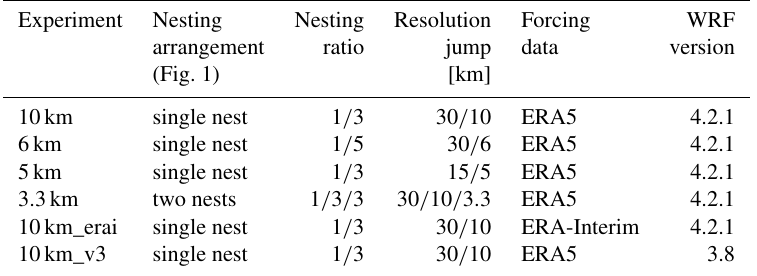
Table 1. Experiment names and the WRF model configuration. The nesting ratio refers to the grid of the relative parent domain, as shown in Fig. 1. Resolution jump is the grid spacing of the outer and inner grids. Experiment Nesting Nesting Resolution Forcing WRF arrangement ratio jump data version (Fig. 1) [ km ] 10km single nest 1 / 3 30 / 10 ERA5 4.2.1 6km single nest 1 / 5 30 / 6 ERA5 5km single nest 1 / 3 15 / 5 3.3km two nests 10km_erai single nest 1 / 3 30 / 10 ERA-Interim 10km_v3 single nest 1 / 3 30 / 10 ERA5